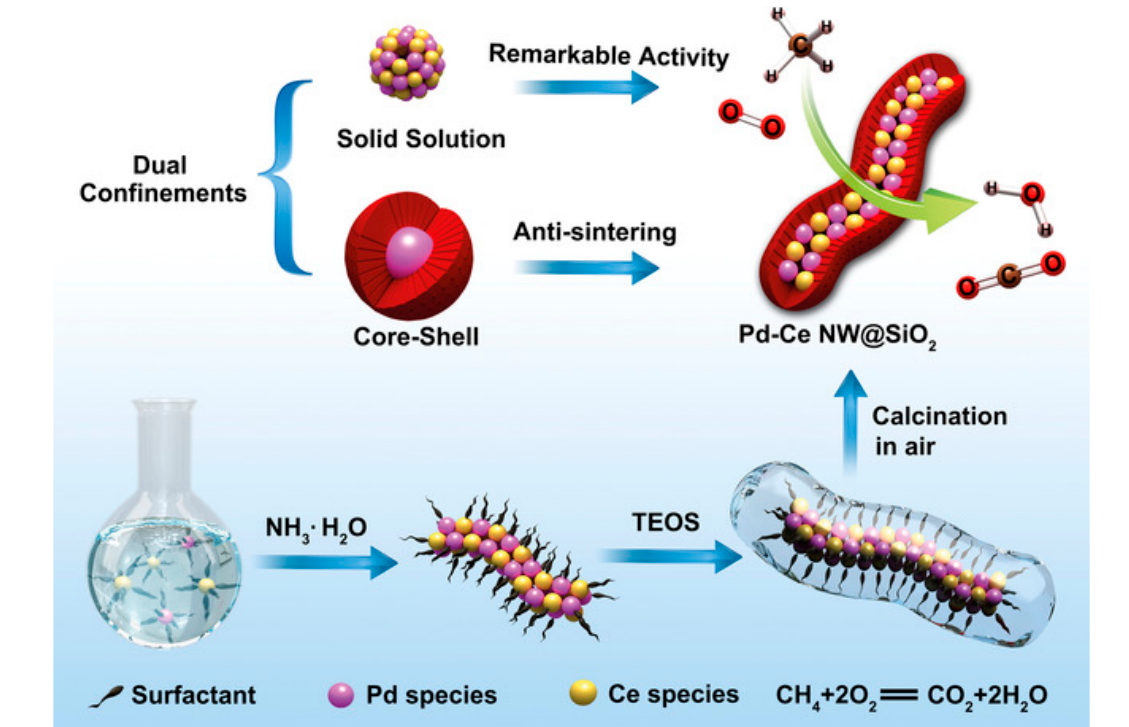
Figure 17. The formation process and catalytic application of Pd-CeNW@SiO 2 . Reprinted with permission from Ref. [97]. Copyright 2022, copyright John Wiley and Sons.